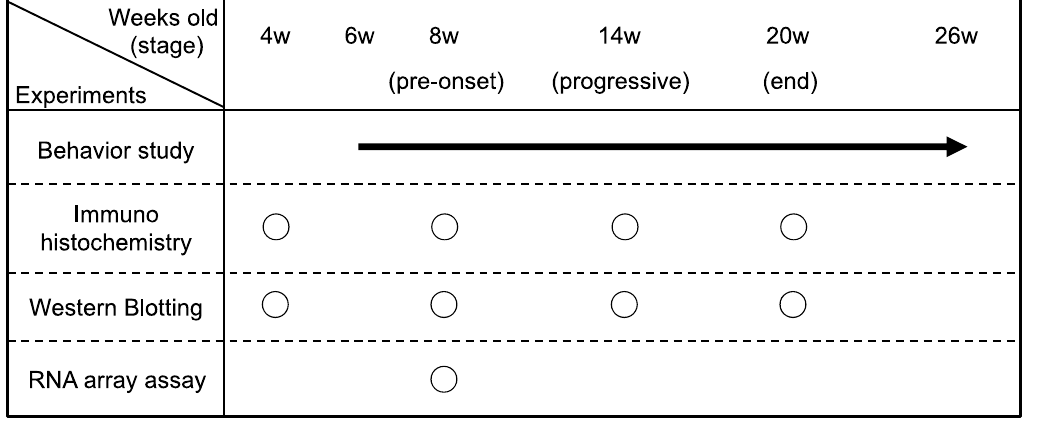
Figure 1. The timeline of experiments. We defined 8, 14, and 20 weeks old as the pre-onset, progres- sive, and end stages, respectively. The behavioral study was performed from 6 weeks until death. Immunohistochemistry and Western blotting were analyzed at 4, 8, 14, and 20 weeks. An RNA array was performed at 8 weeks.